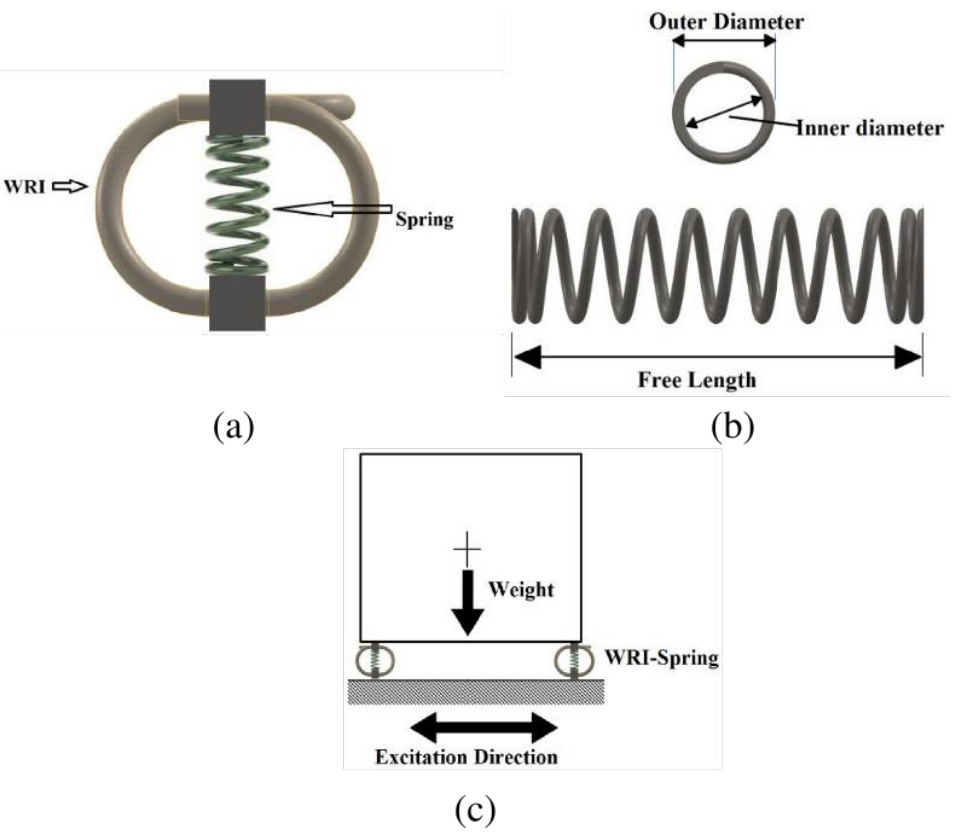
Figure 6. S-WRI and its position under a piece of equipment: ( a ) S-WRI; ( b ) spring; ( c ) S-WRI under equipment. Table 2. Spring specifications.